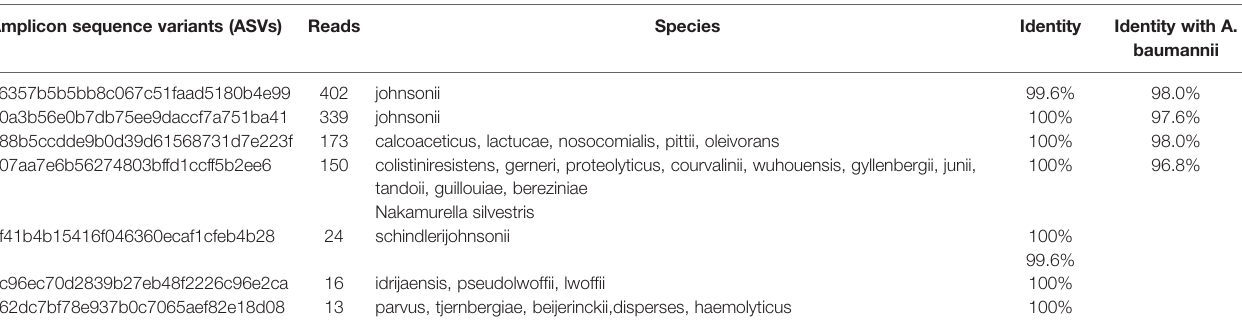
TABLE 3 | Sequences of the genus Acinetobacter. Amplicon sequence variants